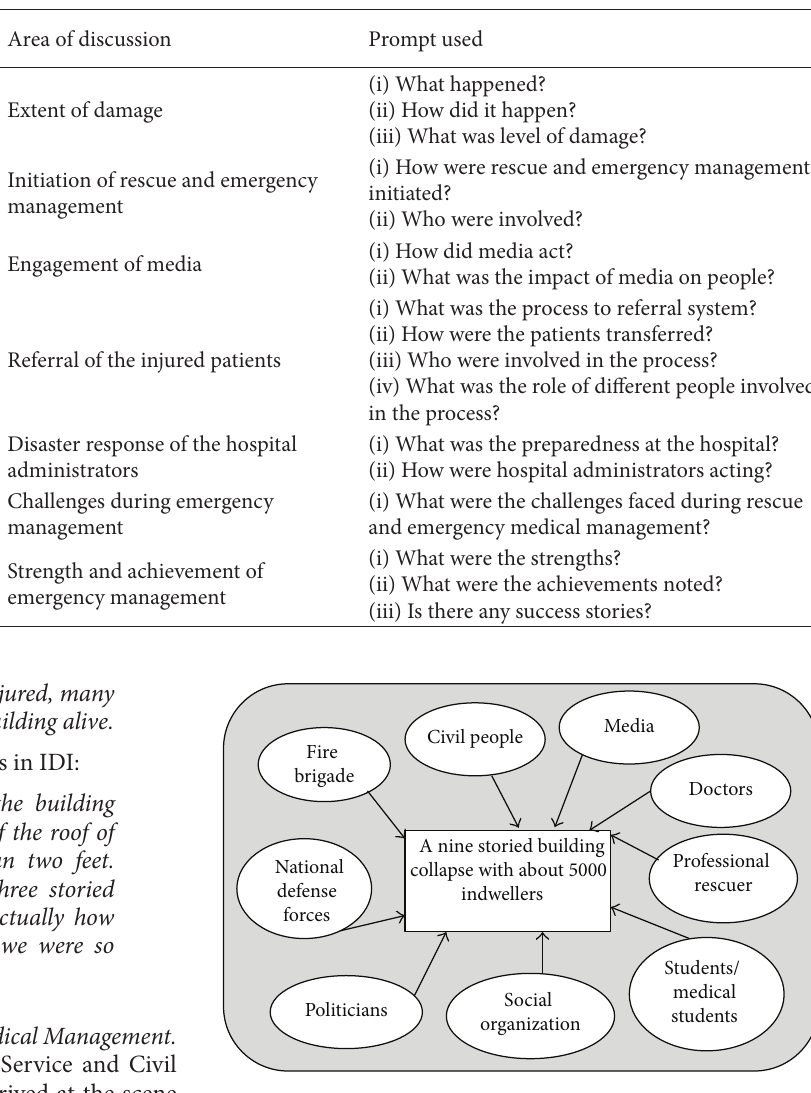
Table 1: Checklist for IDIs and FGD.